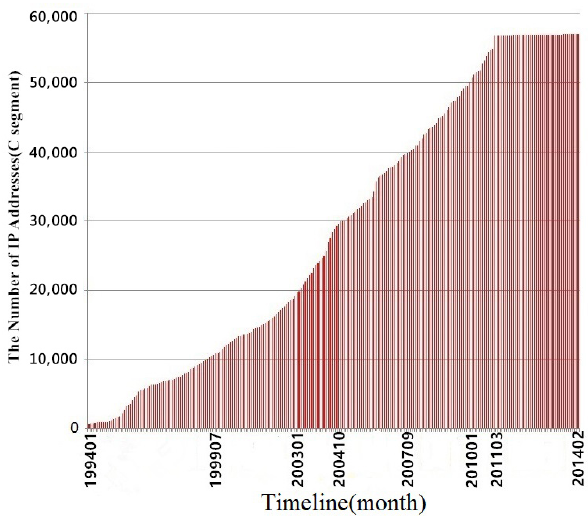
Figure 1. Statistics of IPv4 addresses assigned by CERNET (1994–2014)